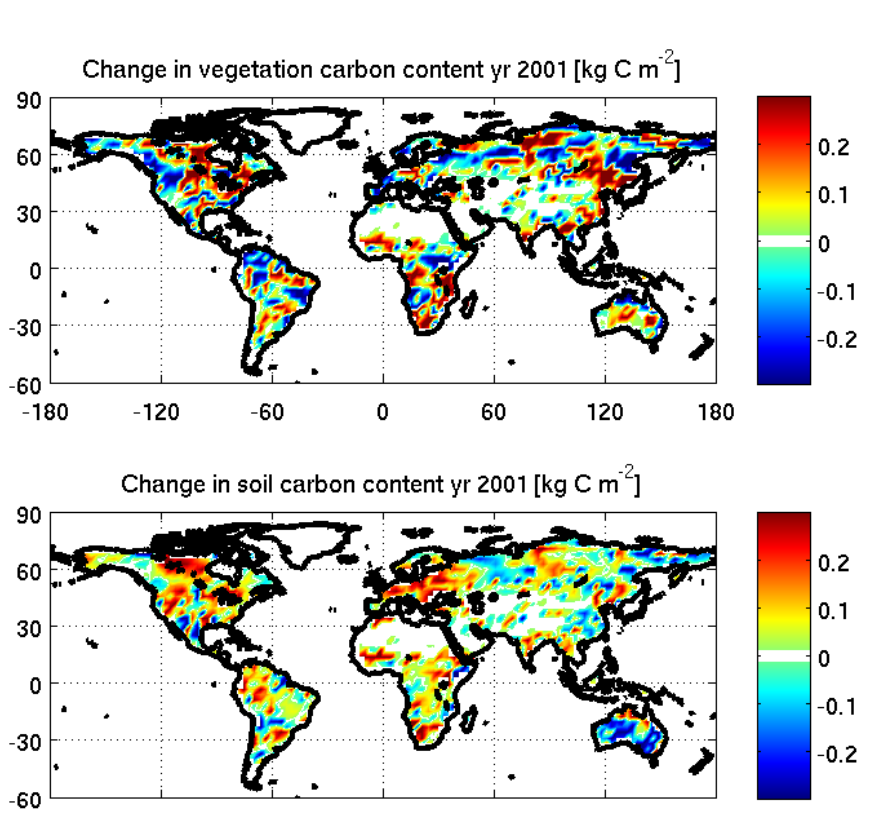
Fig. 3. Regional change in (top) vegetation and (bottom) soil carbon content due to the Mount Pinatubo eruptions computed at year